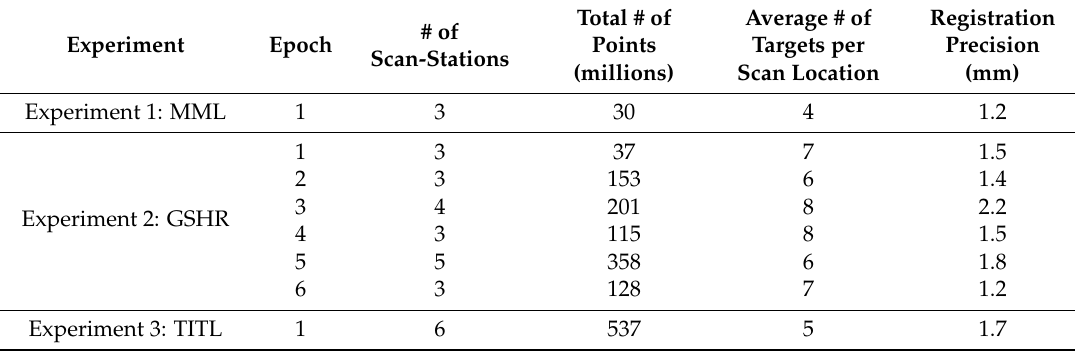
Table 1. # of scan-stations, average # of targets per scan-station and registration precision of the all